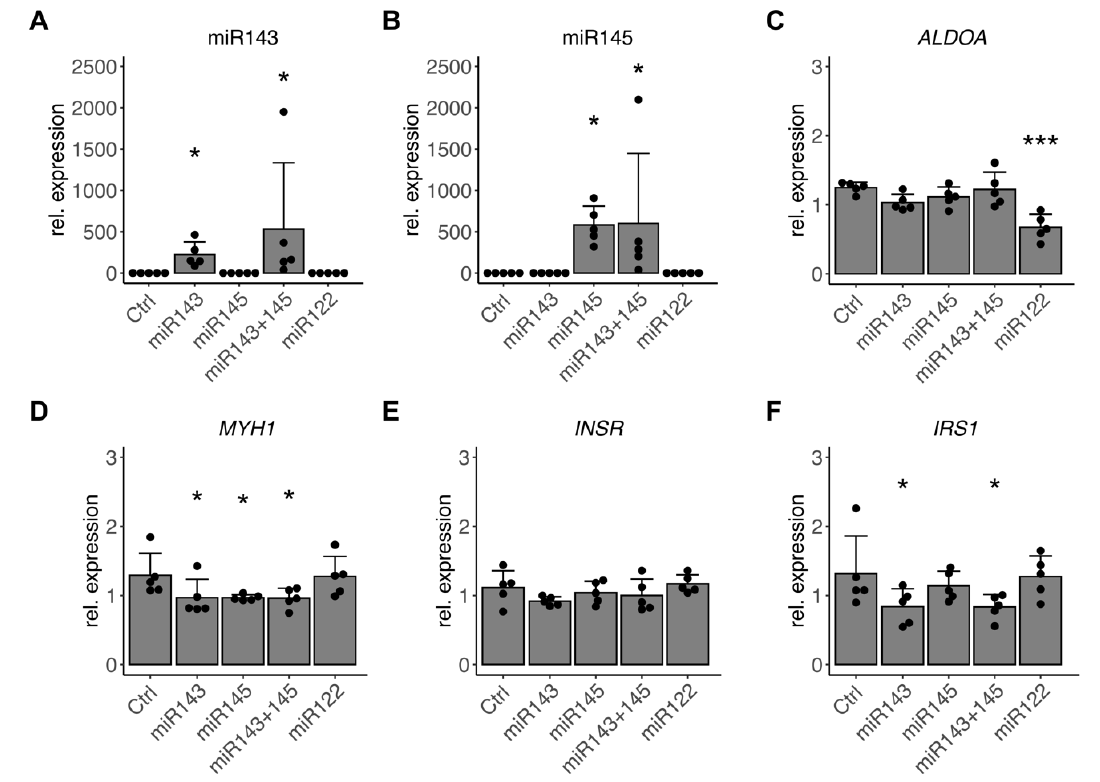
Figure 6. miR-143/145 downregulate components of skeletal muscle differentiation and insulin signaling. Primary human myoblasts ( n = 5) were differentiated towards myotubes for 5 days in the absence of FBS and subsequently transfected with miR-143-3p, miR-145-5p, a combination of miR-143-3p and miR-145-5p, control miR-122-5p, or vehicle control (Ctrl) for the last 48 h. Abundance of mature miRNA ( A ) miR-143-3p, ( B ) miR-145-5p was detected by qPCR. ( C – F ) mRNA levels of ( C ) miR-122-5p target ALDOA , ( D ) MYH1 , ( E ) INSR , and ( F ) IRS1 were detected by qPCR. All qPCR data were normalized to individual donors and reference RNU6 (miRNAs) or mean of RPS28 and TBP (mRNA). Individual datapoints are displayed, bars represent mean ± SD. All data were analyzed using one-way ANOVA with Fisher’s LSD post-hoc test, * p < 0.05, *** p < 0.001 vs. Ctrl. Table 3. Regulation of potential targets by miR-143/145 cluster in differentiated skeletal muscle cells. miR143 p vs. Ctrl miR145 p vs. Ctrl miR143 + 145 p vs. Ctrl